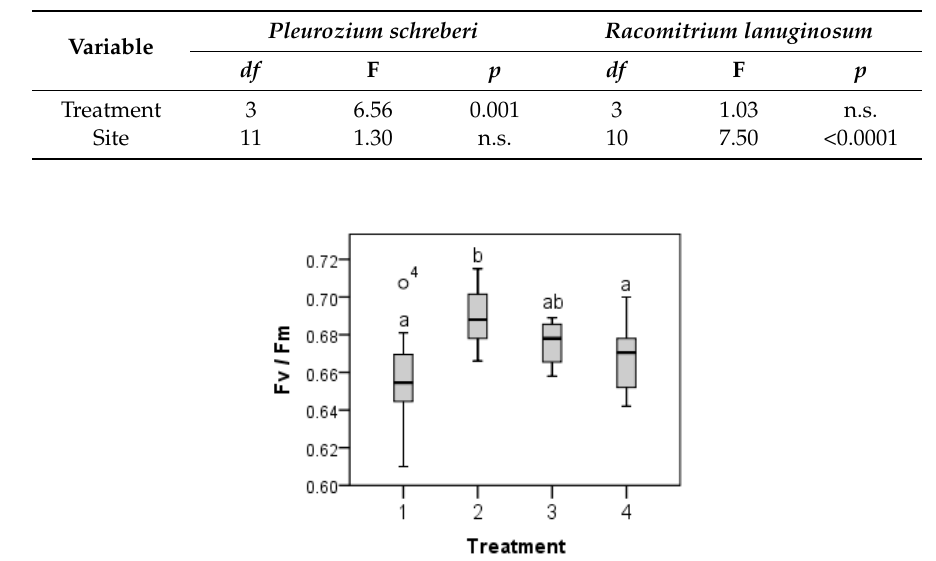
Figure 2. Box plots of Fv/Fm in P. schreberi from 12 different sites, in response to short-term (13 days) temperature treatment ex situ . Different letters indicate significant difference (determined by Fisher’s PLSD post-hoc test). Treatments in day/night temperatures: 1 = 10/5 °C; 2 = 20/10 °C; 3 = 25/15 °C; 4 = 30/20 °C. The median in the box plot is indicated by the horizontal line in the box, the box indicates the 25th and 75th percentiles and the bars indicate the 10th and 90th percentiles. n = 12 (sites). Site effects were non-significant (Table 2). Table 3. Results of t-test on Fv/Fm before and after short-term ex situ temperature treatment (day/night temperature: (1) 10/5 °C; (2) 20/10 °C; (3) 25/15 °C; (4) 30/20 °C.) in P. schreberi and R. lanuginosum . n.s. = no significant difference.